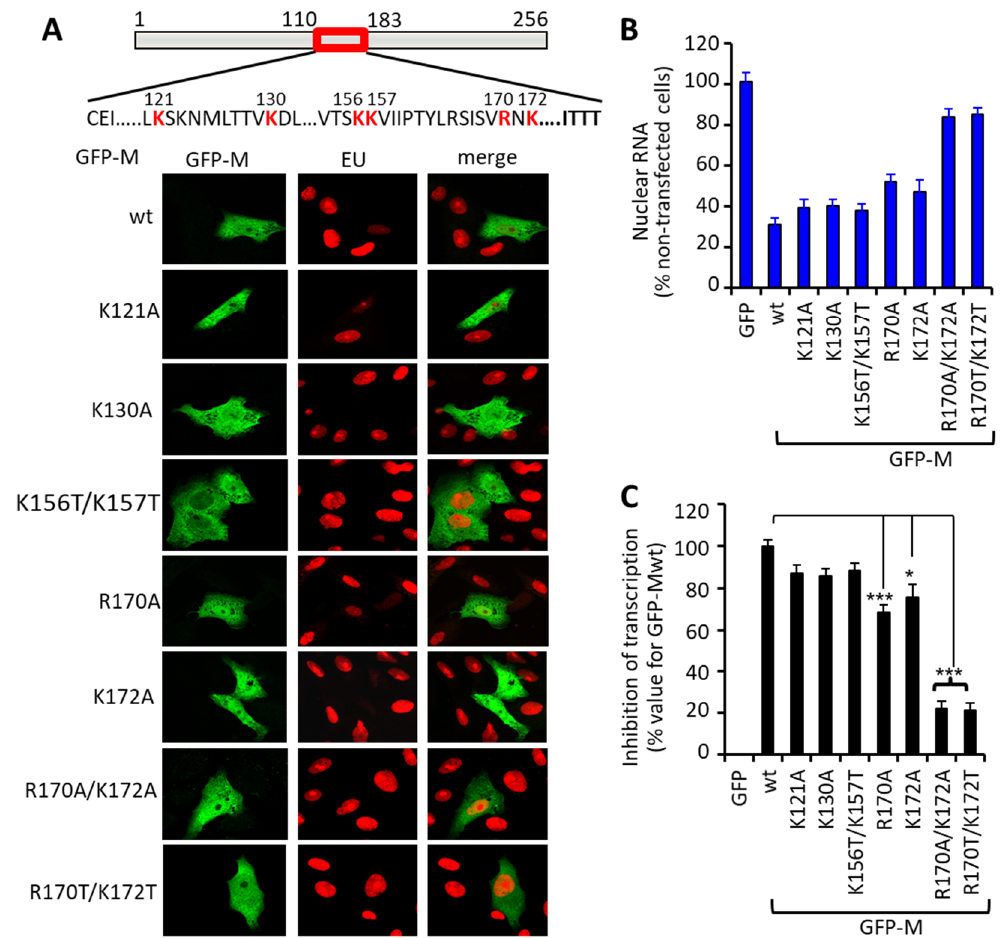
Figure 3. RSV M residues R170 and K172 within the nucleotide binding domain are critical for transcriptional inhibition in living cells. ( A ) Schematic representation as per Figure 2A of the sites of point mutation (red) within the central nucleotide binding domain of M, within the GFP-M fusion constructs used. Representative CLSM images of Vero cells expressing the indicated GFP-M constructs treated with EU, fixed, permeabilized, and stained for de novo synthesized RNA as per the legend to Figure 1 are shown. ( B ) Quantitative analysis for inhibition of de novo RNA synthesis ( n = 20) as per the legend to Figure 1. ( C ) Results from ( B ) are expressed as percent inhibition of transcription relative to that effected by GFP-Mwt. Significant differences are indicated, ** p < 0.01, *** p < 0.001.